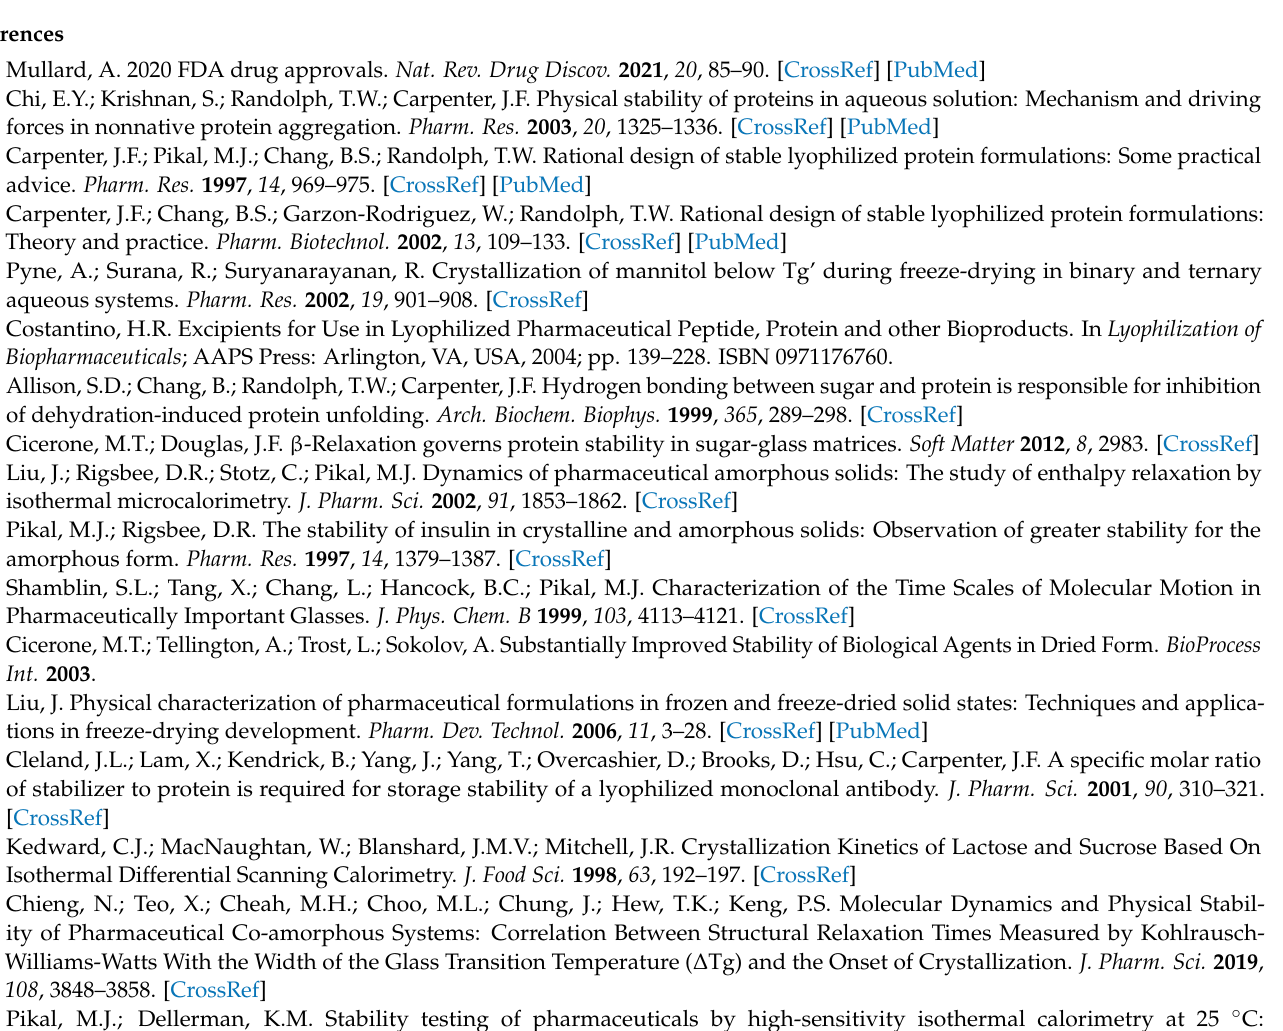
Figure A1. Monitoring of freezing of the products. The first 10 h of the random nucleation process ( a ) and the controlled nucleation process ( b ) are presented. The black line represents the temperature set point for the shelfs, the colored solid lines the actual product temperature and the dashed line the chamber pressure. Arrows demonstrate the ice nucleation process. The pressure drop and rise at approximately 1.5 h in the controlled nucleation is needed to introduce the ice fog in the chamber.